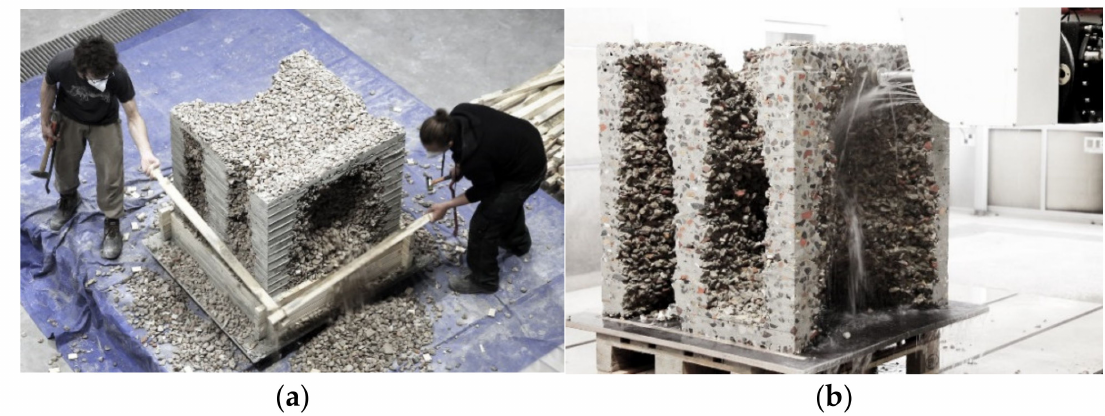
Figure 16. Demoulding and post-processing: ( a ) dismantling of the stackable formwork elements; ( b ) milling of the edges.